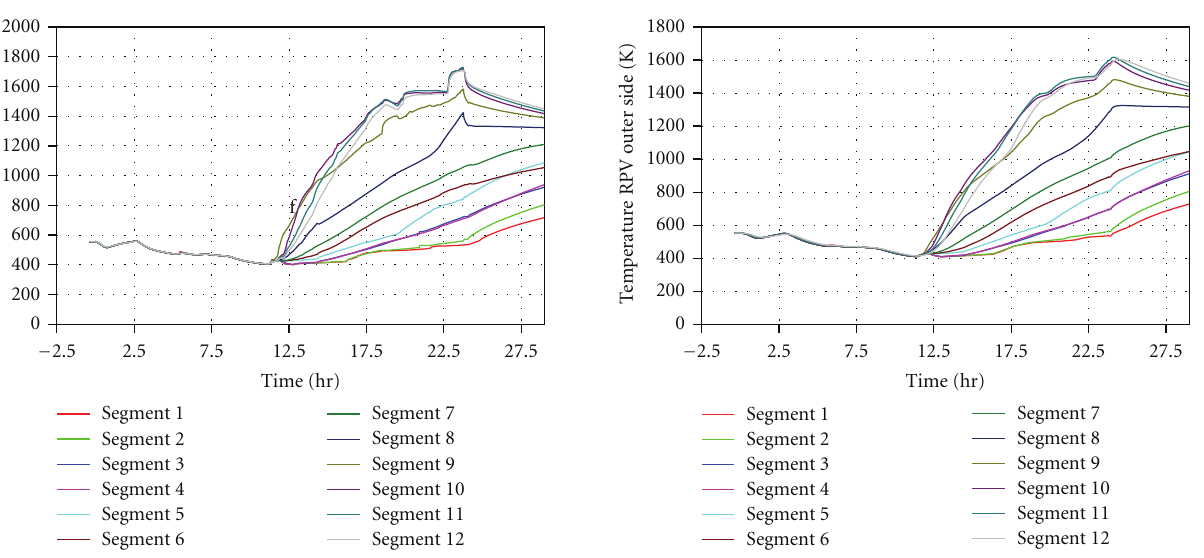
This means that creeping e ff ects are probably proceeding